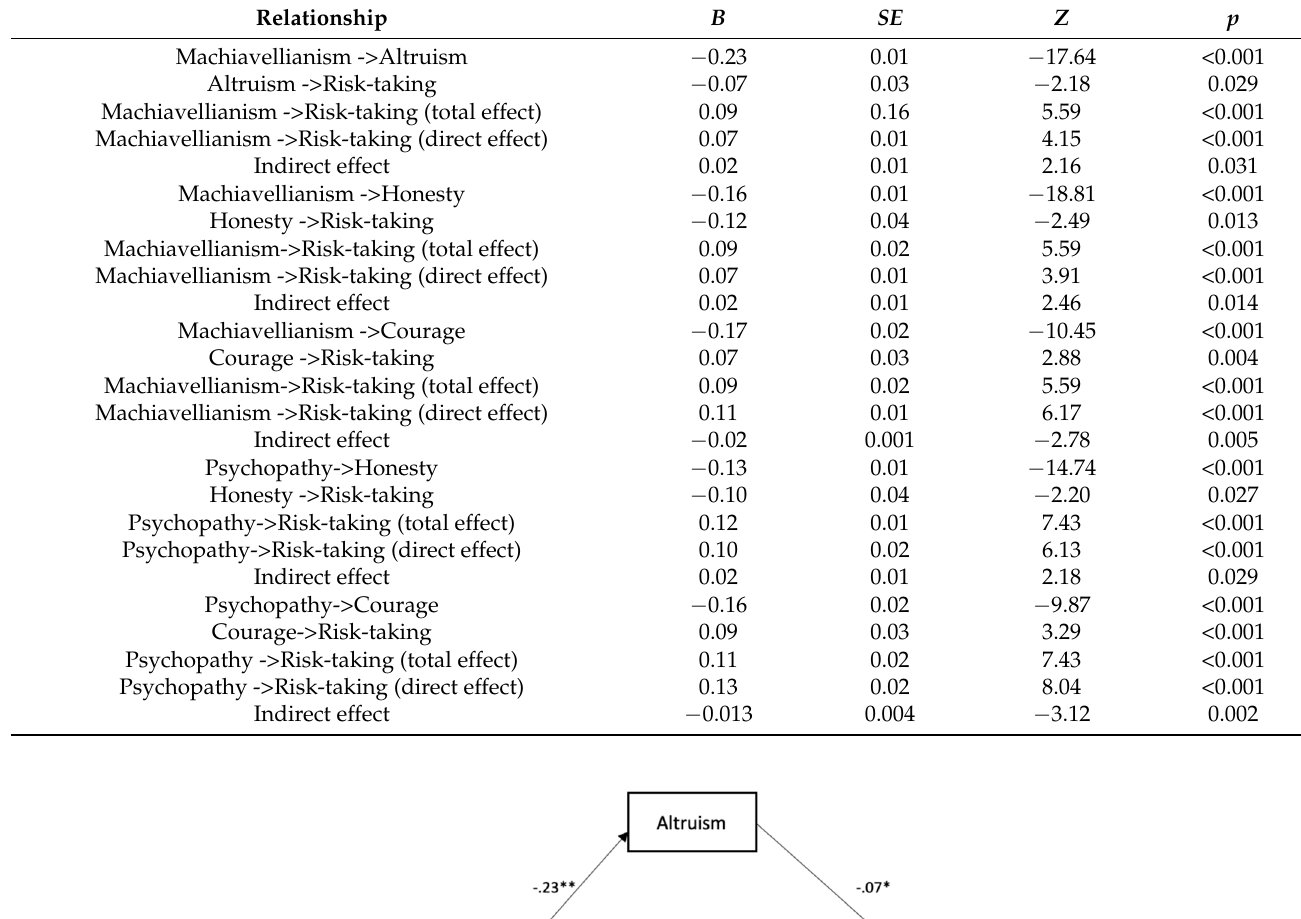
Table 3. Mediation analysis regarding the role of altruism, honesty, and courage in the relationship between the Dark Triad traits and risk-taking at work in the case of firefighters.